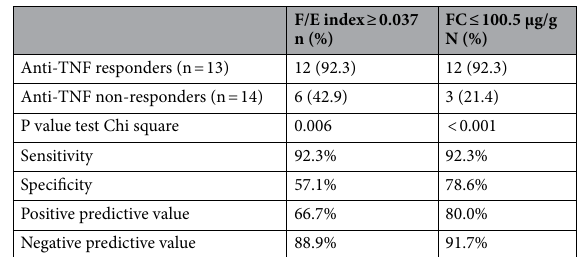
Table 2. True positives, false positives, sensitivity, specificity and predictive values obtained in the sample analyzed using the F/E index and